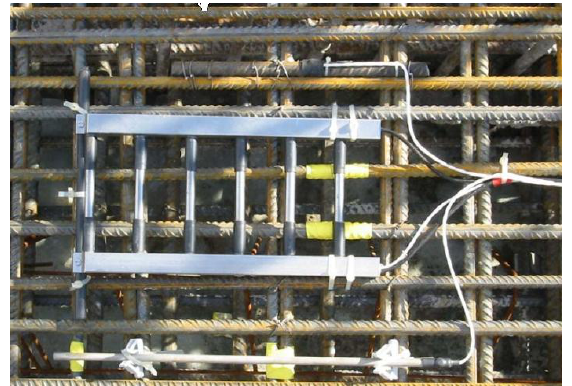
Figure 1. Anode-Ladder-System sensor.